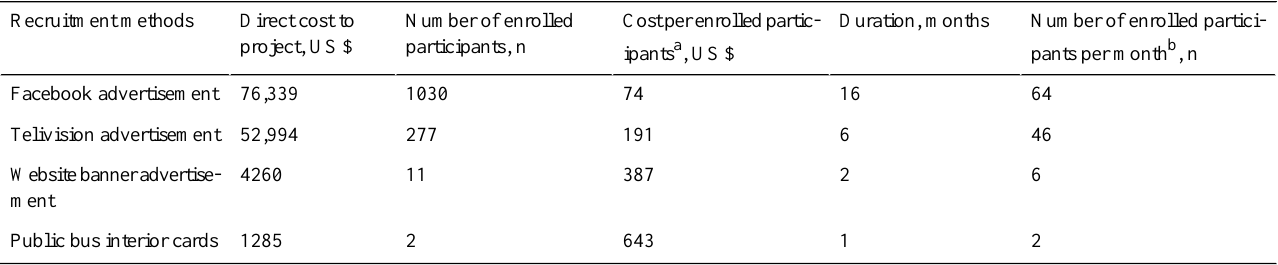
Table 2. Recruitment cost of strategies directly charged to the project.